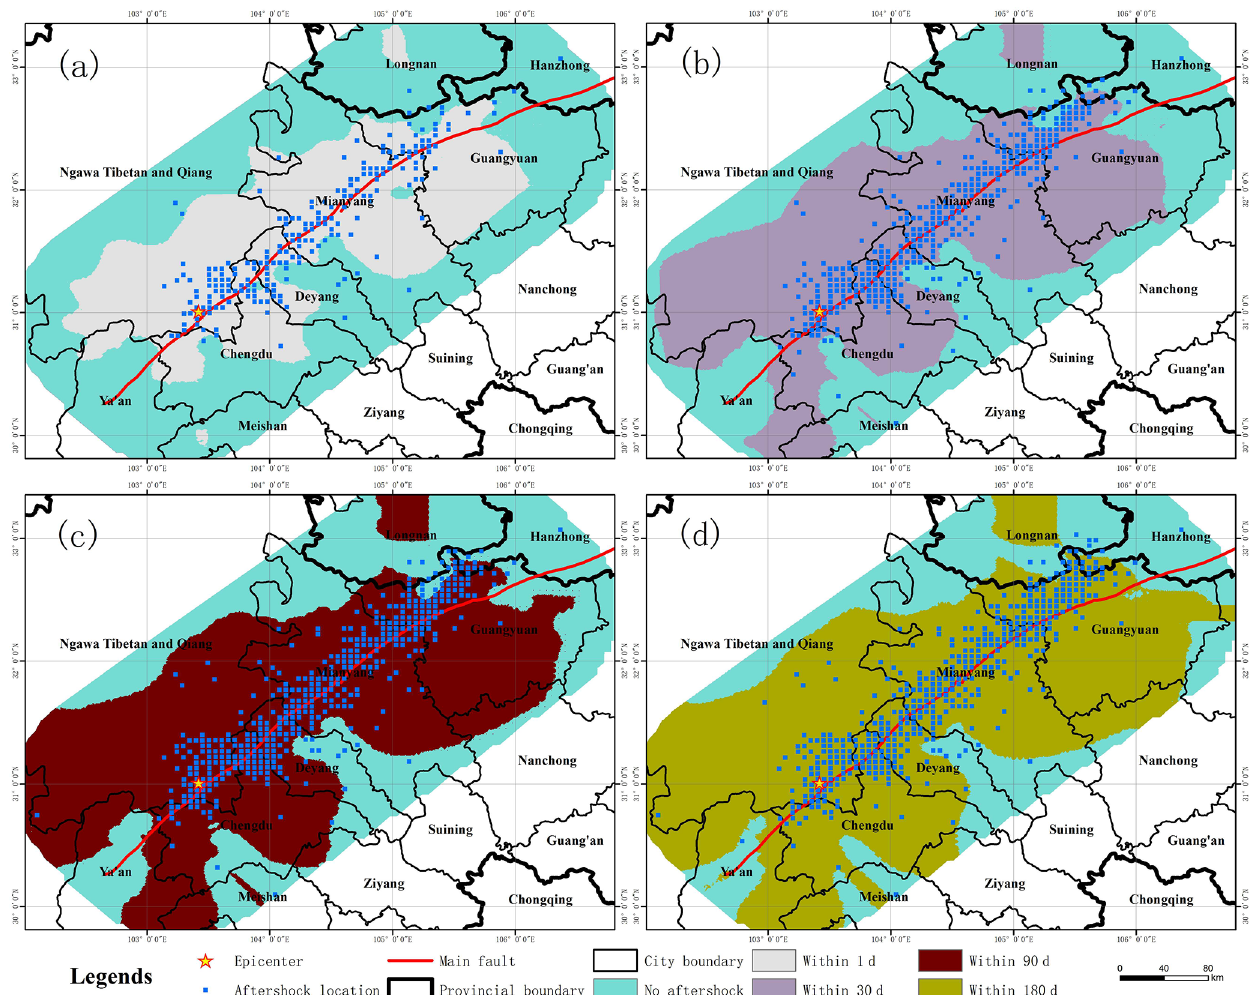
Figure 6. Aftershock damage patterns of the Wenchuan earthquake at multiple timescales. Panels (a) through (d) show the aftershock damage pattern within 1, 30, 90 and 180d, respectively. The blue dots indicate the actual location of aftershocks at the corresponding